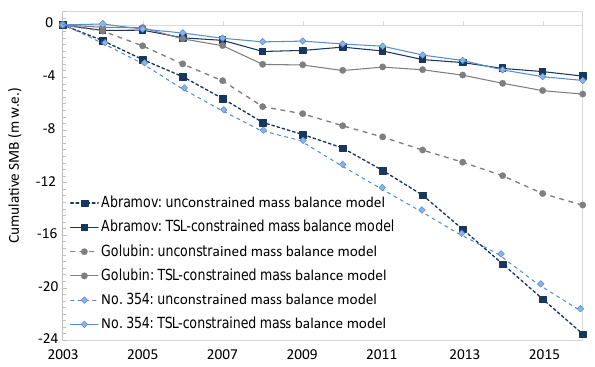
Figure 12. Comparison of the cumulative SMB derived from un- constrained mass balance modelling to the results obtained from TSL-constrained modelling from 2004 to